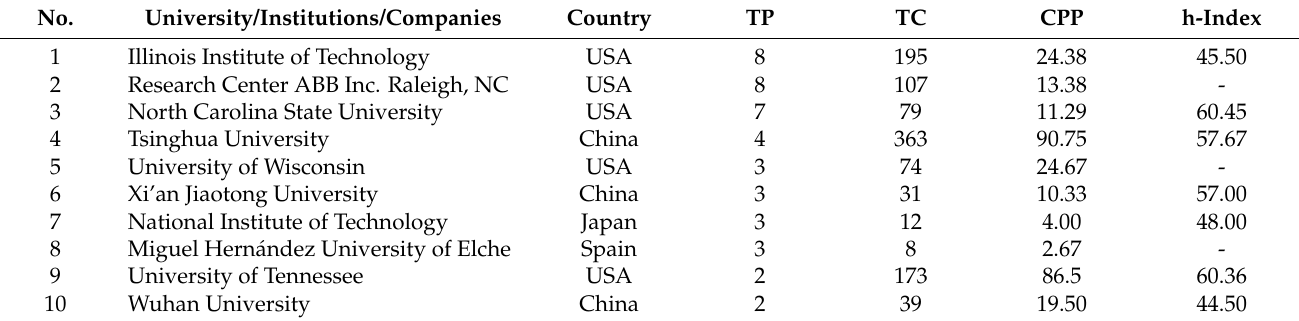
Table 8. Top ten list of influential universities/institutions/companies for publication.